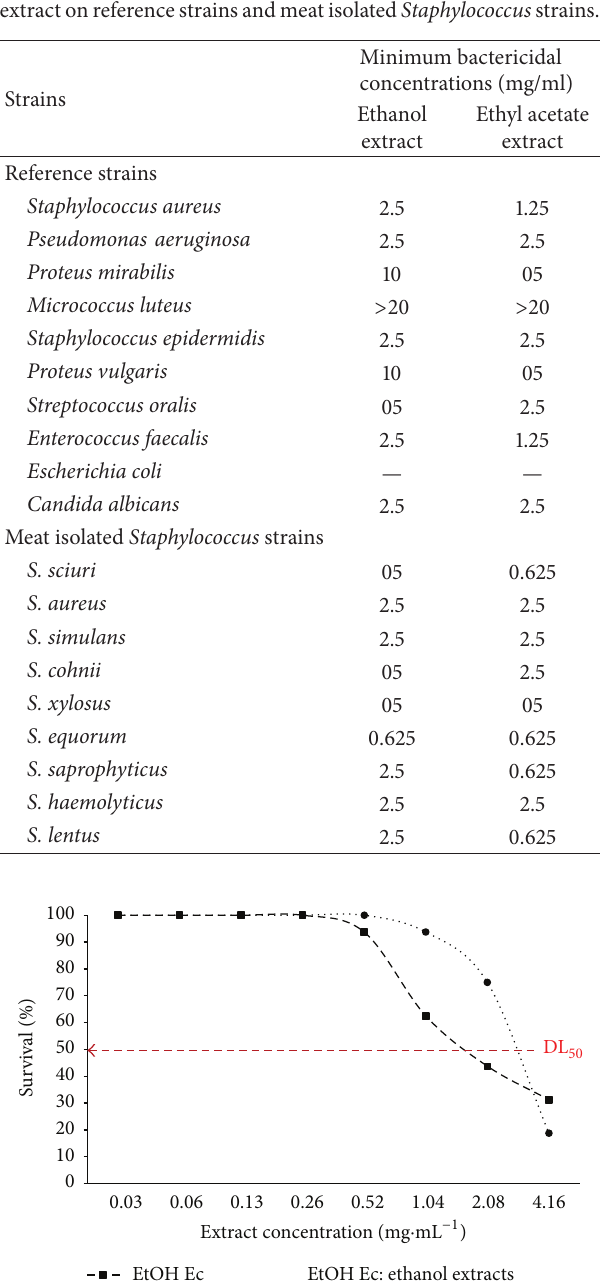
Table 4: Minimum bactericidal concentrations of C. nitida ’s bark extract on reference strains and meat isolated Staphylococcus strains.